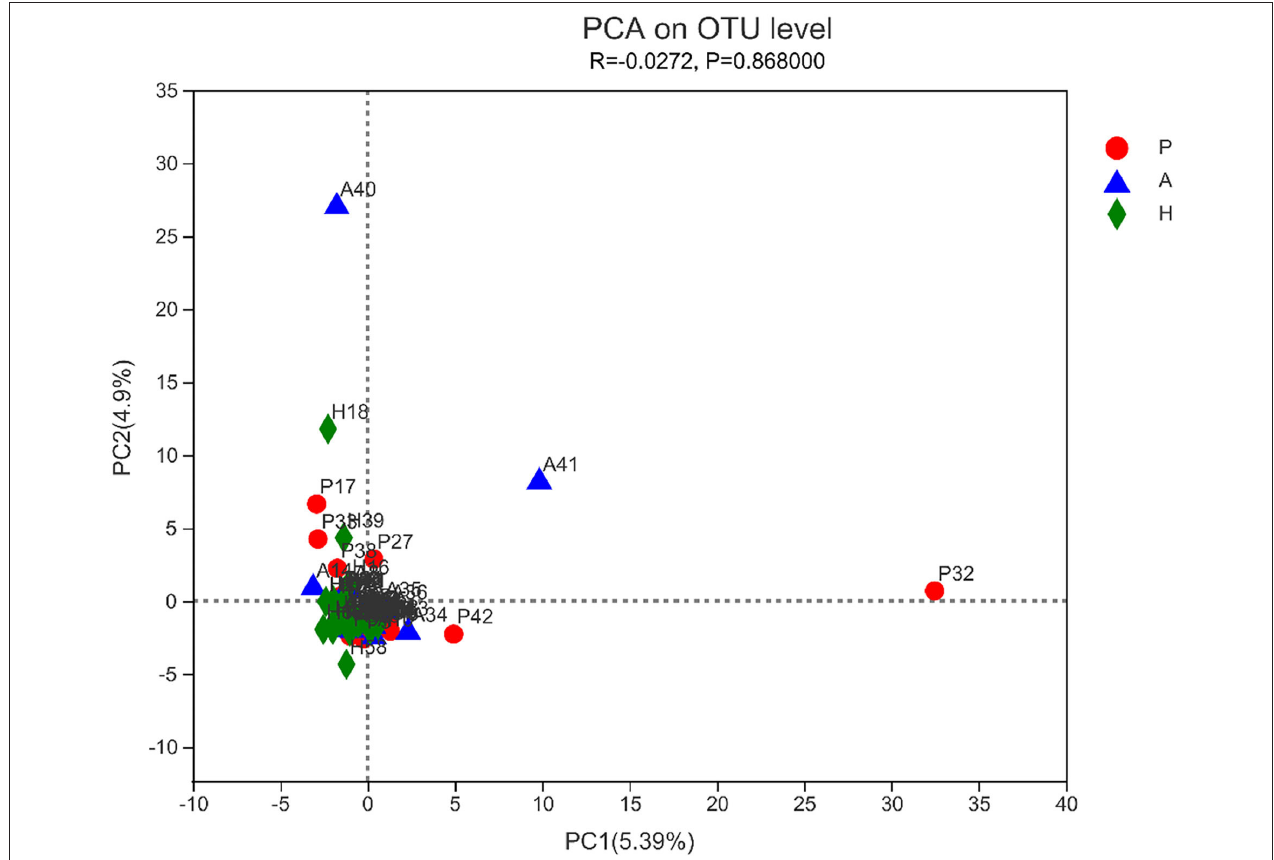
FIGURE 9 | Beta-diversity of fungi was determined using principal component analysis (PCA). There was no obvious clustering of samples by